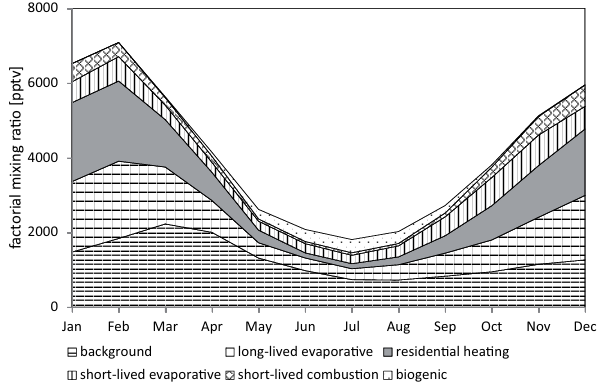
Figure 5. Mean monthly variability of the contributions from the six